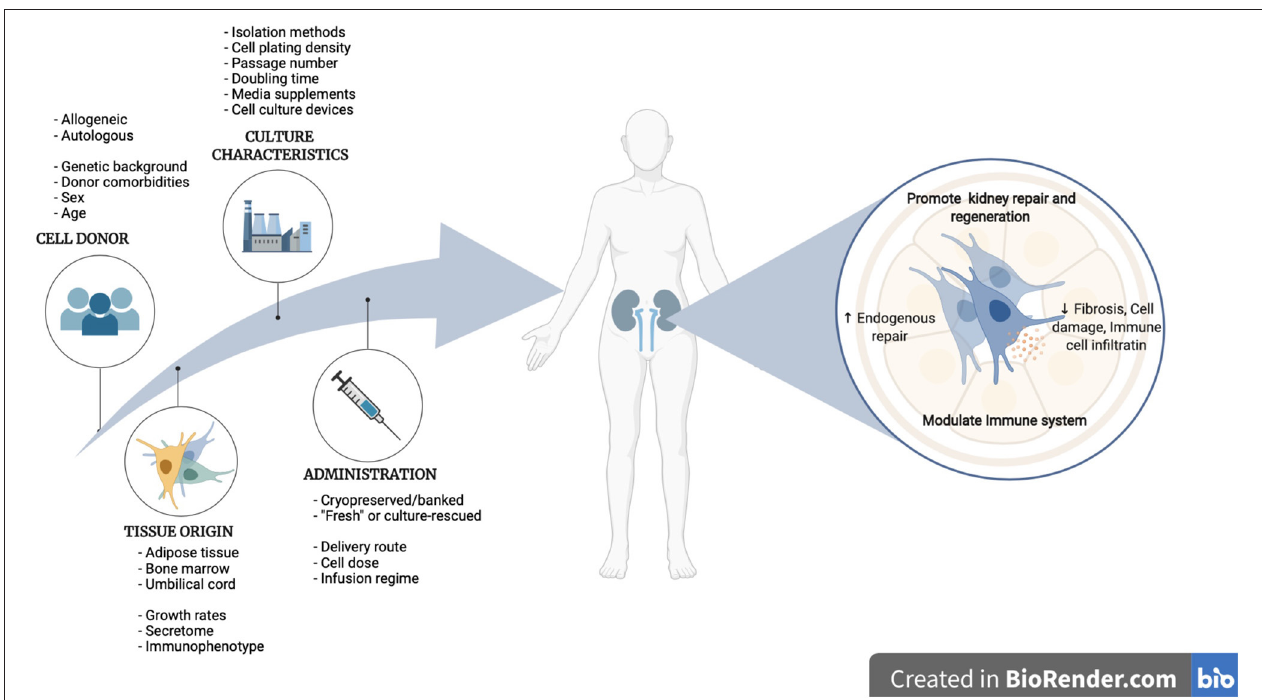
FIGURE 5 | Roadmap to clinical translation of MSC therapies for kidney disease, from MSC manufacturing variables to therapeutical benefits in renal